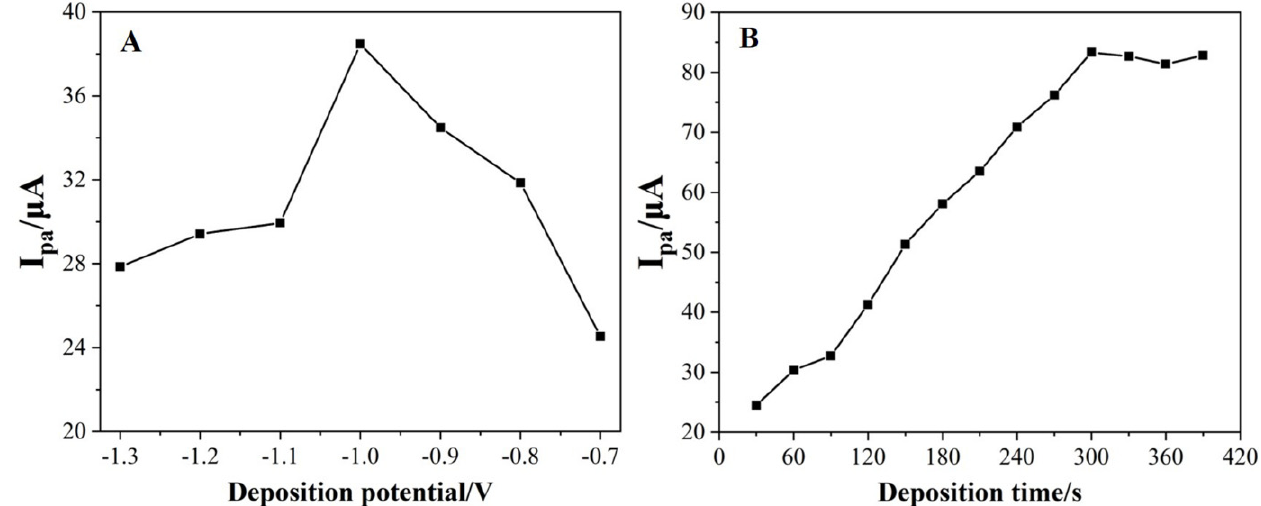
Figure 5. ( A ) The effect of the deposition potential on the I pa of 1.0 μ M of Pb 2+ with the deposition time fixed at 120 s. ( B ) The effect of the deposition time on the I pa of 1.0 of μ M Pb 2+ with the deposition potential fixed at − 1.0 V.